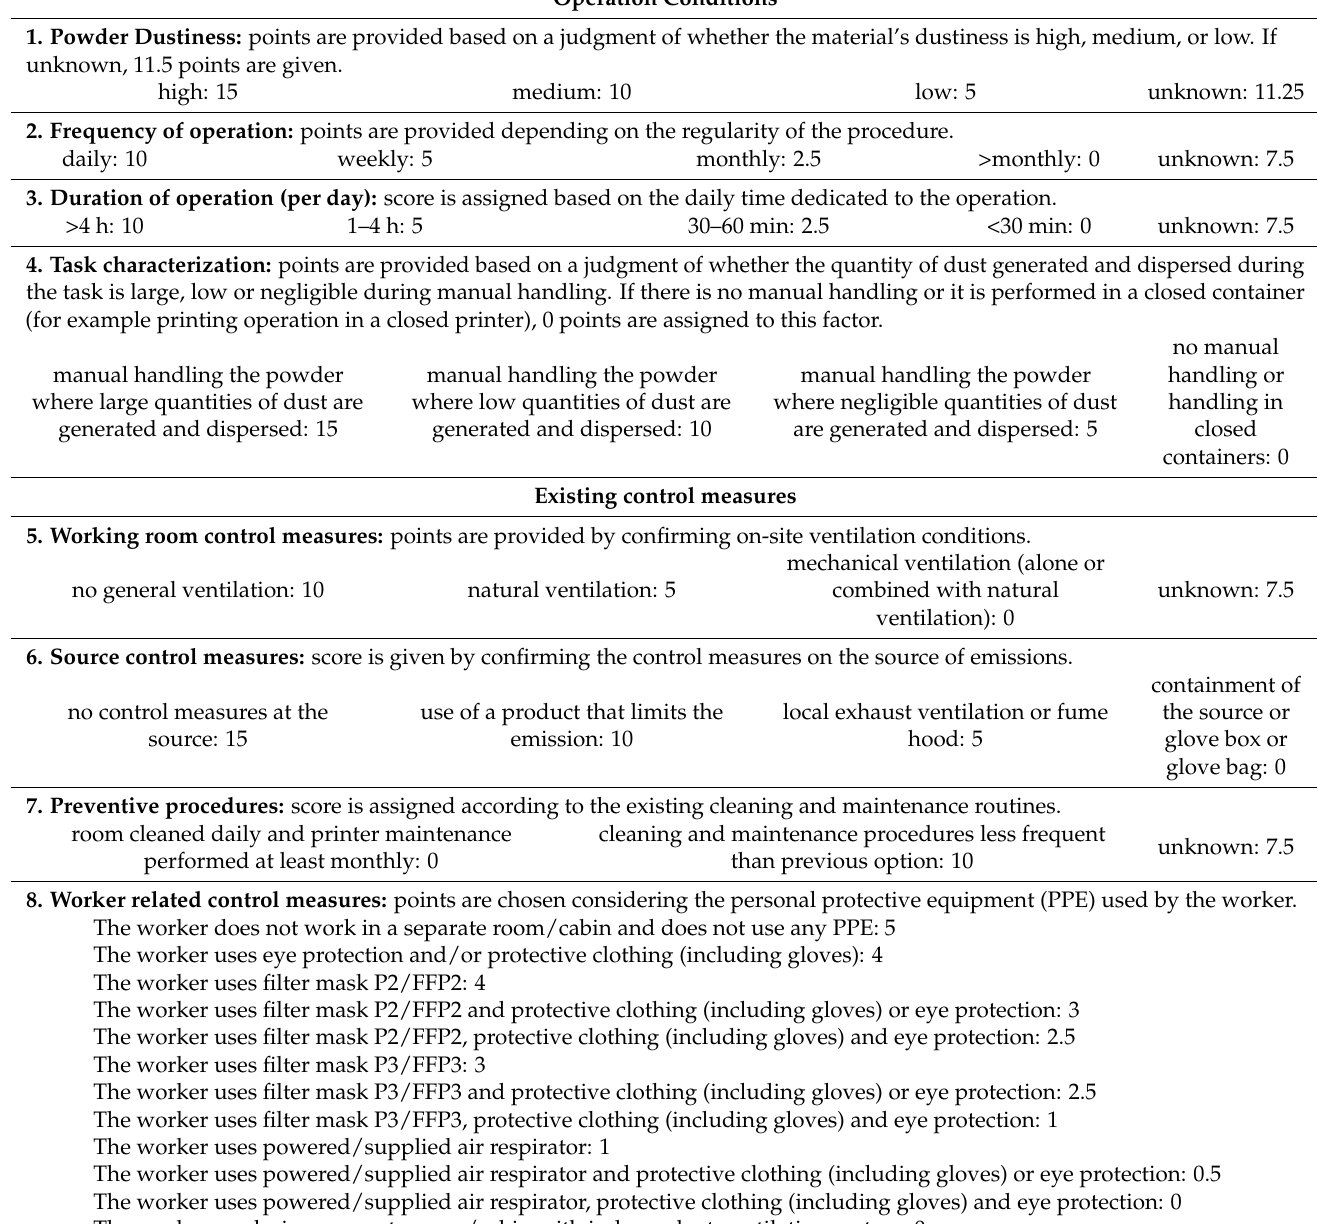
Table 8. Exposure factors and points per factor. Operation